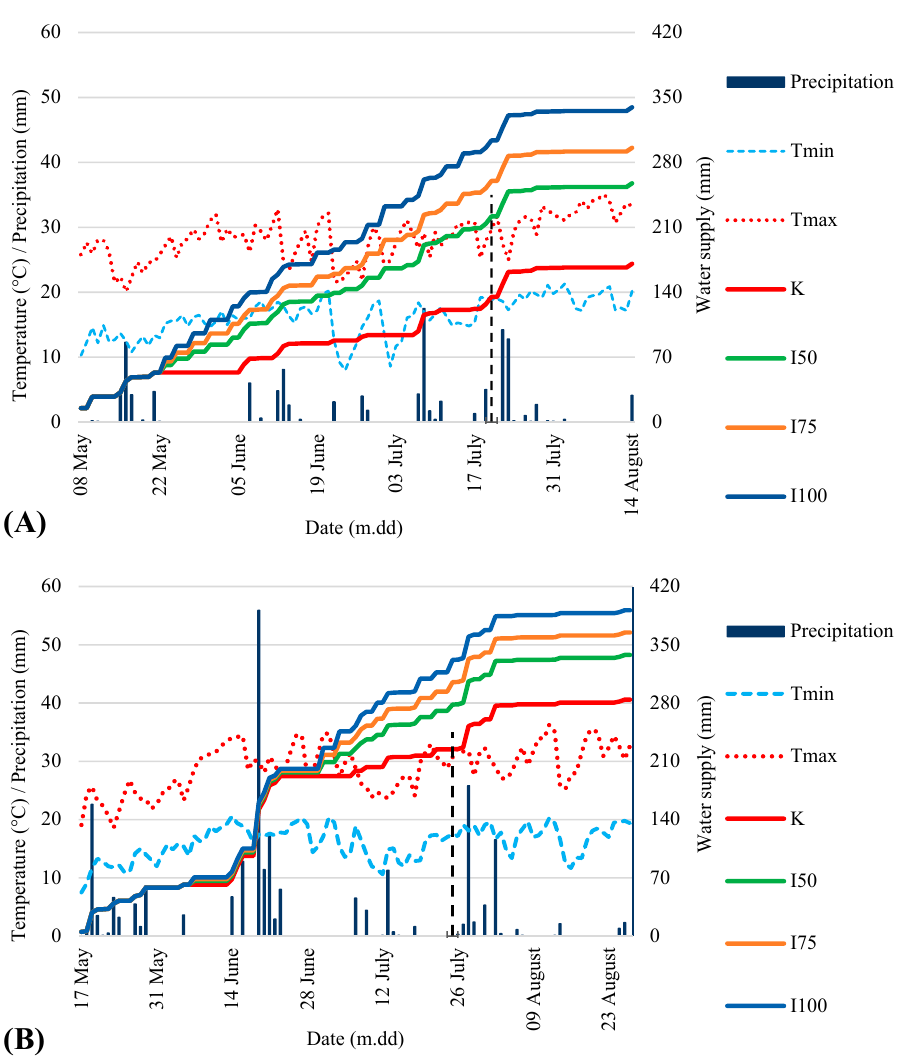
Figure 1. Trend of maximum (Tmax) and minimum (Tmin) temperature, precipitation, and water supply for the four irrigation treatments in 2018 ( A ) and 2019 ( B ). Vertical dash line represents the date of last irrigation event.